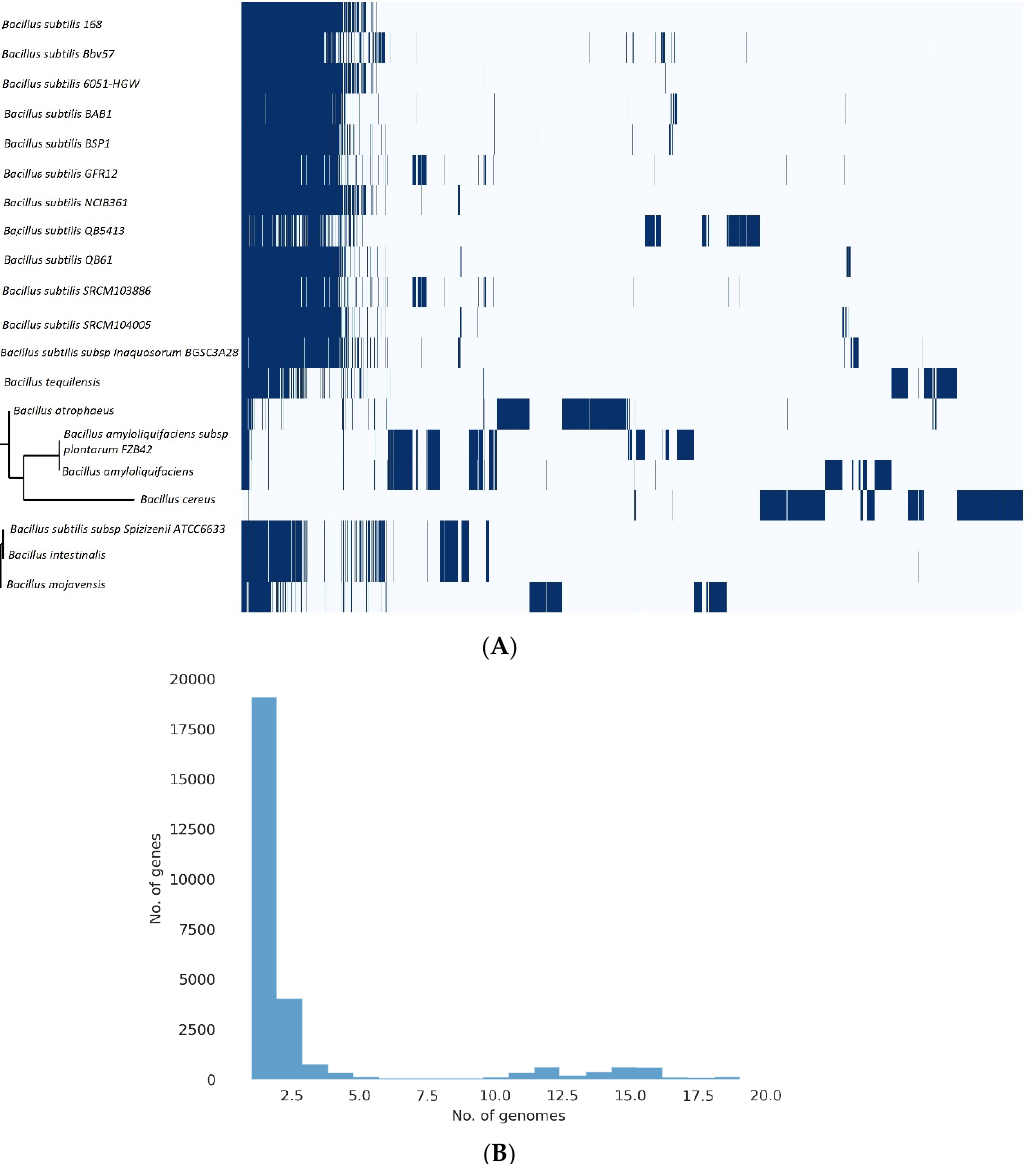
Figure 6. Bacillus subtilis pangenome. The pangenomes of six Bacillus sp. were determined using the Roary matrix. A total of 28,404 sets of orthologous proteins were found. ( A ) A heatmap showing the gene presence (dark blue) or absence (light blue) in each of the 20 strains. A phylogeny built based on the core genes is shown on the left, and the species names are indicated on the right. ( B ) A histogram displaying the distribution of genomes per gene is found within.